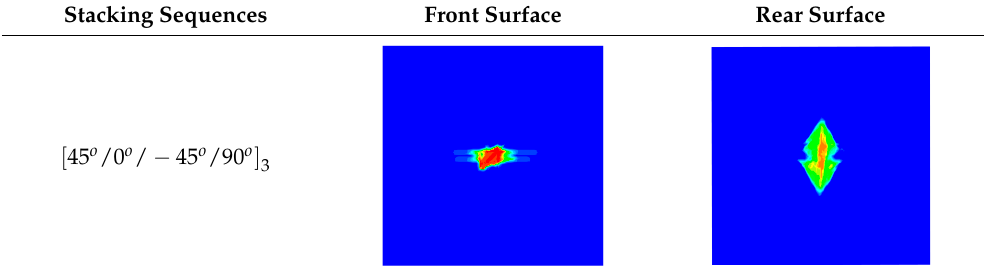
Table 6. Cont. Stacking